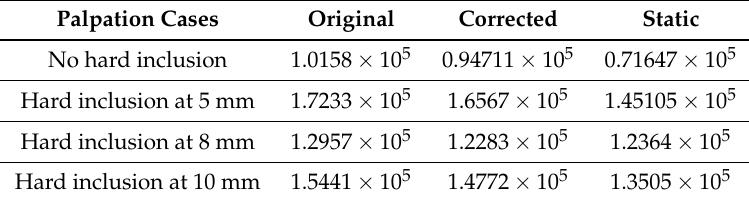
Table 2. The average YM during palpation (Unit: Pa).